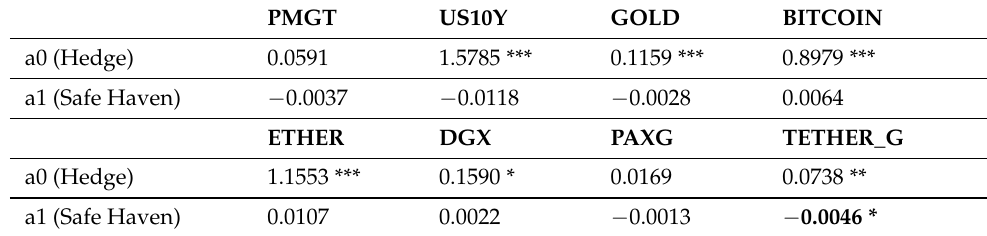
Table 1. Regression results from univariate GJR-GARCH safe-haven regressions à la